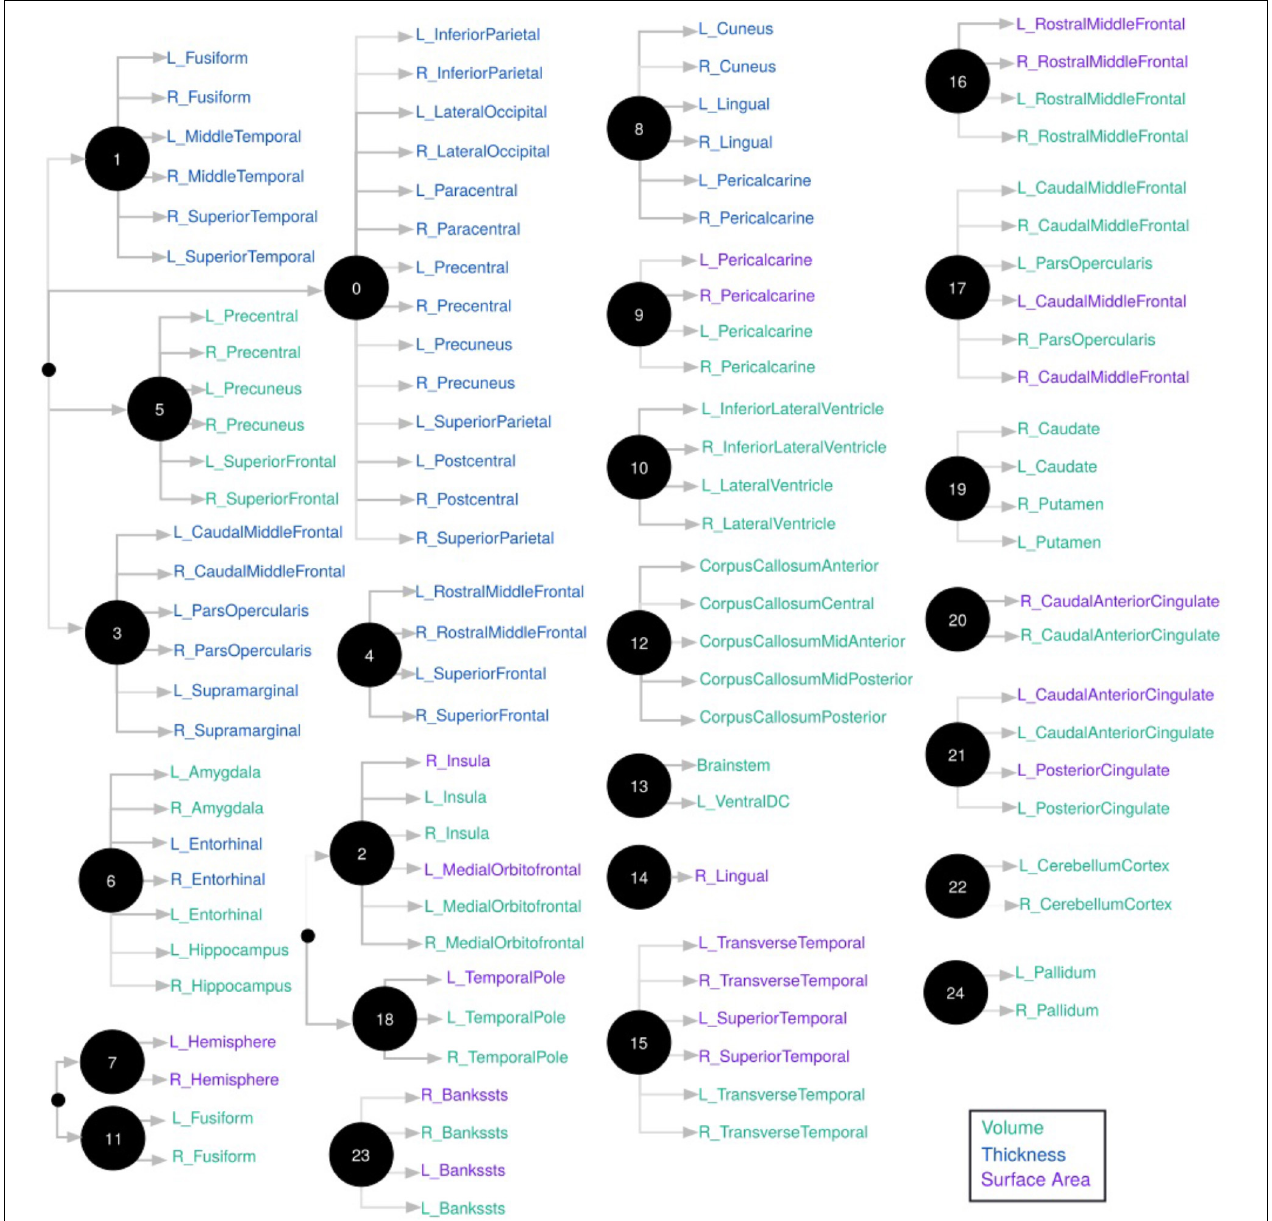
FIGURE 3 | Hierarchical representation of brain measures constructed by CorEx. Using CorEx across a panel of > 200 residualized gray matter measures we constructed a hierarchical network based on the joint information shared between measures. We identified a set of 25 latent factors that represent optimal total correlation across measures and factors. Latent factors are represented by circular nodes and numbered accordingly. The colors indicate measurement type, defined in the legend on the bottom right, with thickness measures in blue , cortical volumes in green , and surface area in purple . Gray shaded edges reflect the amount of mutual information shared between connecting nodes; darker edges indicate more shared information. Only the top measurements are shown for each node.